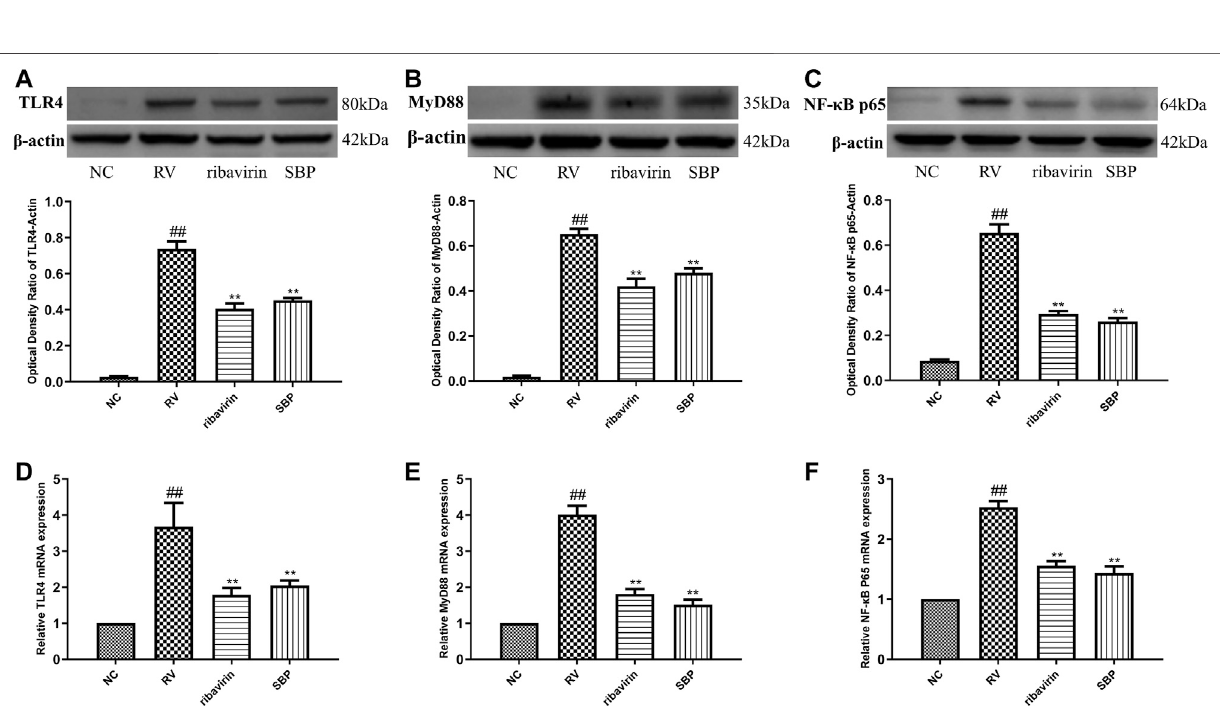
Frontiers in Pharmacology |